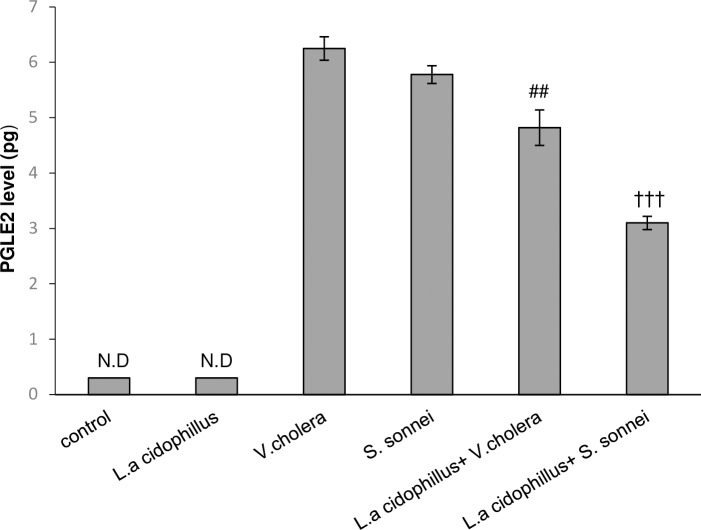
Effect of treatment with L. acidophilus on PGE2 secretion in Caco-2 epithelial cells.PGE2 secretion was significantly elevated following infection with V. cholerae/ S. sonnei and this effect was abolished when the cells were pretreated by L. acidophilus. The data are presented as mean ±SEM. The statistical data (by unpaired two-tailed Student’s t test) were signed when P <0.05. ##significantly different of L.a+V.c+Caco-2 from V.c+Caco-2 cells. ††† significantly different of L.a+S.s+Caco-2 from S.s+Caco-2 cells L.a: Lactobacillus acidophilus, V.c: Vibrio cholerae and S.s: Shigella sonnei. ND: None Detectable.